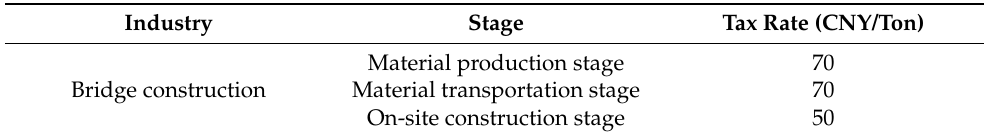
Table 1. Carbon tax rate table for each stage of